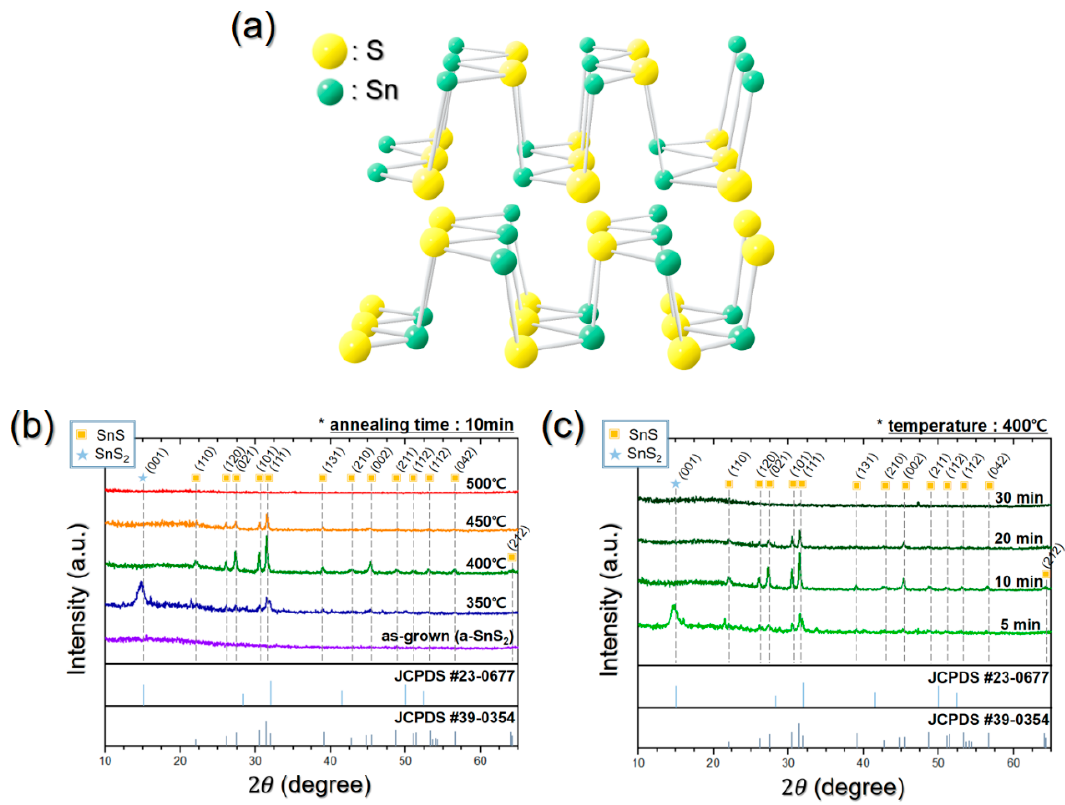
Figure 1. ( a ) Structure of the orthorhombic SnS crystal. X-ray diffraction (XRD) patterns of vacuum-annealed amorphous SnS 2 (a-SnS 2 ) film ( b ) with various temperatures for 10 min and ( c ) various time conditions at 400 °C.